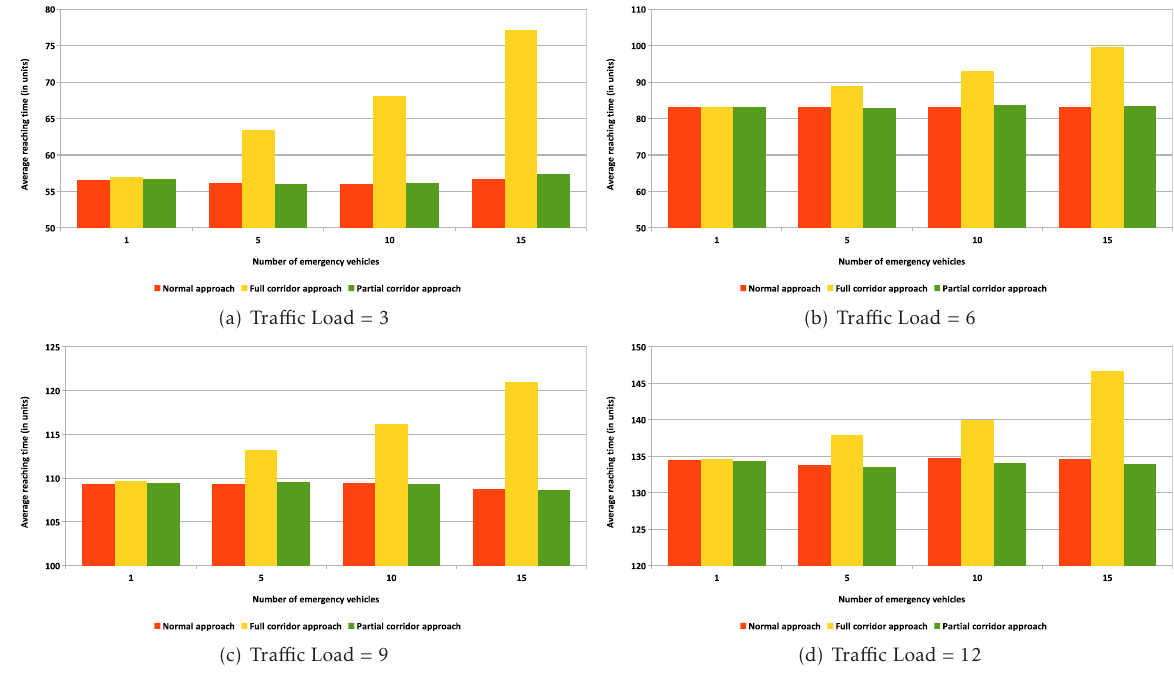
Figure 4. The average reaching time of other vehicles with varying number of emergency vehicles under different traffic loads with 50 other vehicles within a 500-node